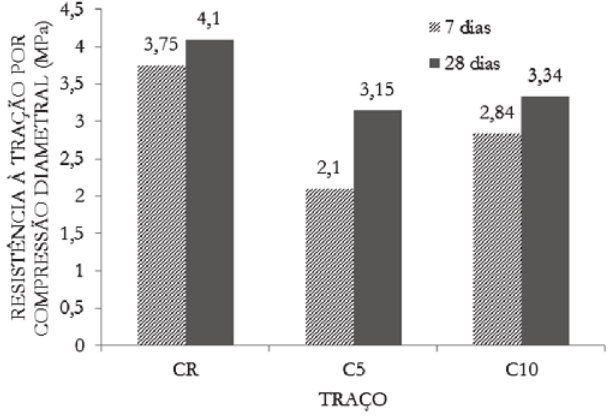
Resistência à tração por compressão diametral, com relação ao tempo de